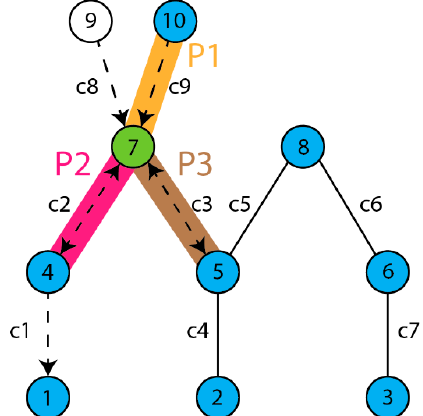
Figure 6. Three possible paths—P1, P2, and P3—to get to element 7. All other paths will be longer than those three. These paths represent the first step of the process and each path will be investigated further in order to define whether additional elements or connections must be tackled due to interdependencies.